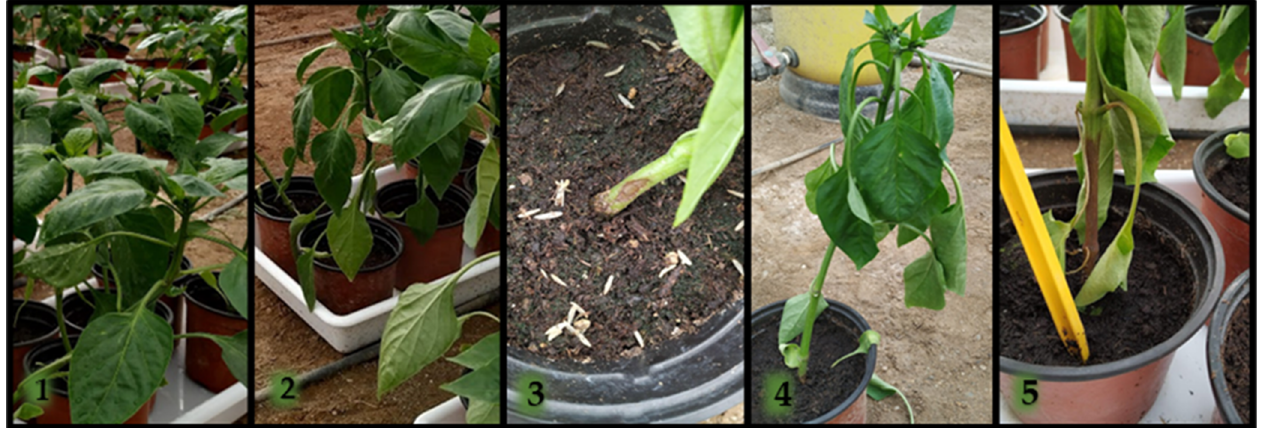
Figure 2. Disease severity scale for Phytophthora capsici ; the same scale is used for P . parasitica. ( 1 ) Healthy plant; ( 2 ) symptoms beginning; ( 3 ) moderate symptoms; ( 4 ) severely a ff ected plant; ( 5 ) dead plant.